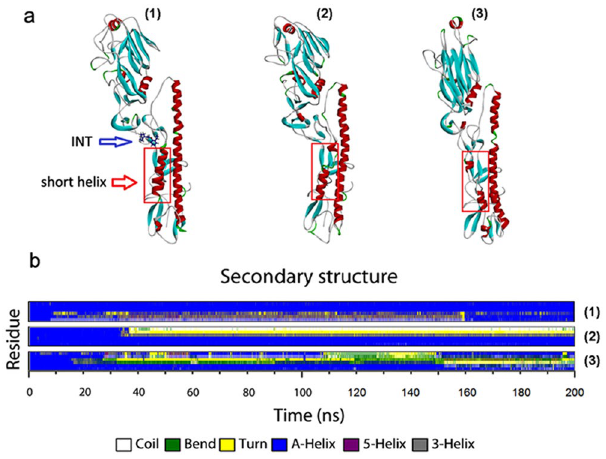
Figure 11. ( a ) Differences in structure between HA bound with INT and free HA under acidic conditions. ( b ) Differences of secondary structures of short helixes between HA bound with INT and free HA during 200 ns molecular dynamics simulations under acidic